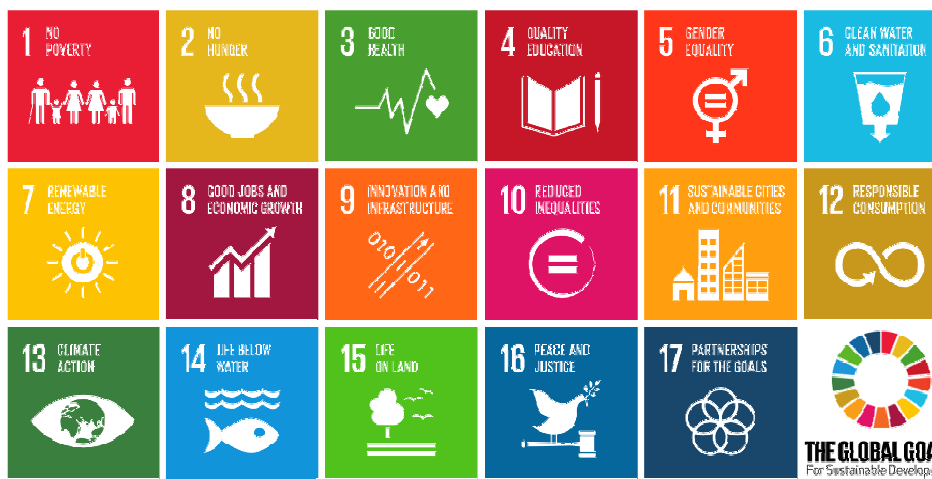
Figure 3: The UN Sustainable Development Goals (SDGs)